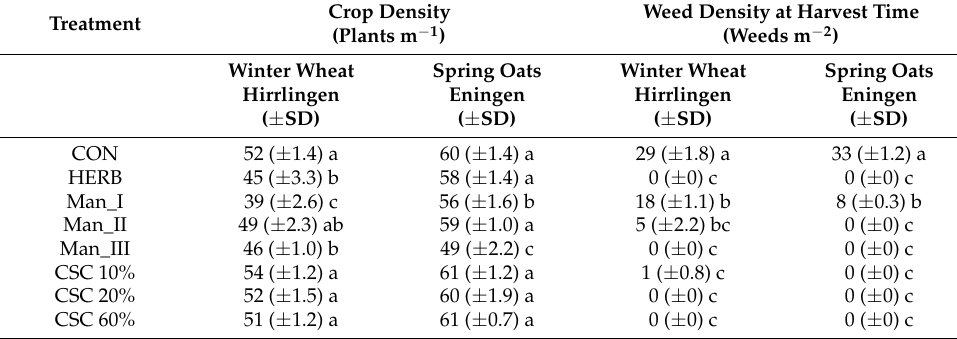
Table 5. Crop density (plants m − 1 , ± SD; p = 0.0053 for Hirrlingen and p = 0.0086 for Eningen) after